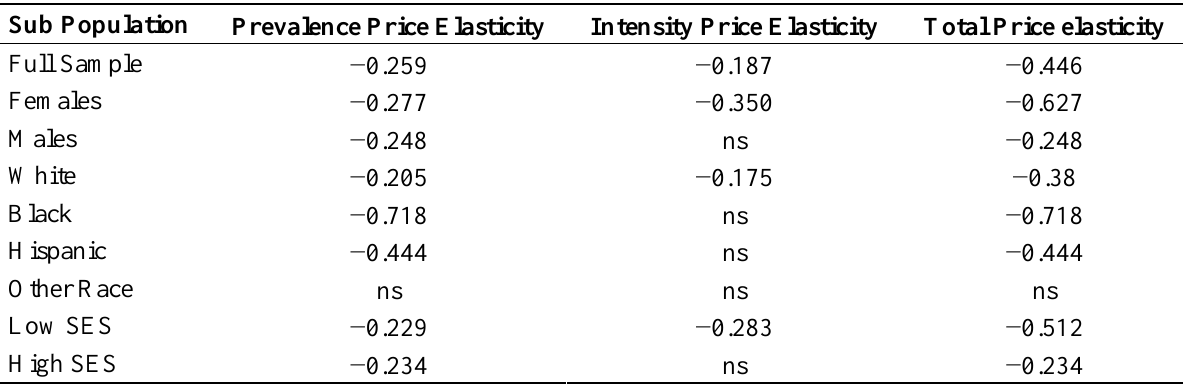
Table 4. Price Elasticity